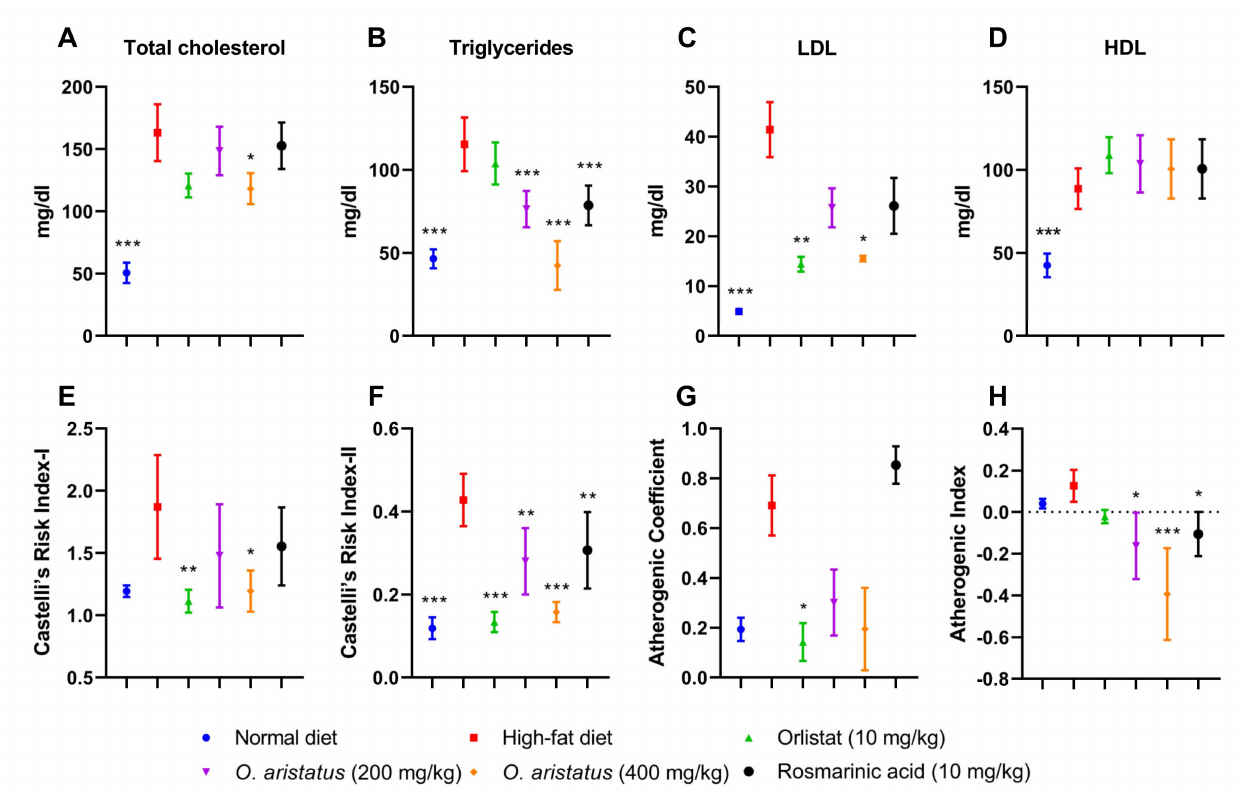
Figure 5. The effects of O. aristatus on serum lipid profile and the atherogenic lipids ratios. * p < 0.05, ** p < 0.01, *** p ≤ 0.001 compared to the high-fat diet group. Values were presented as mean ± SD, n =